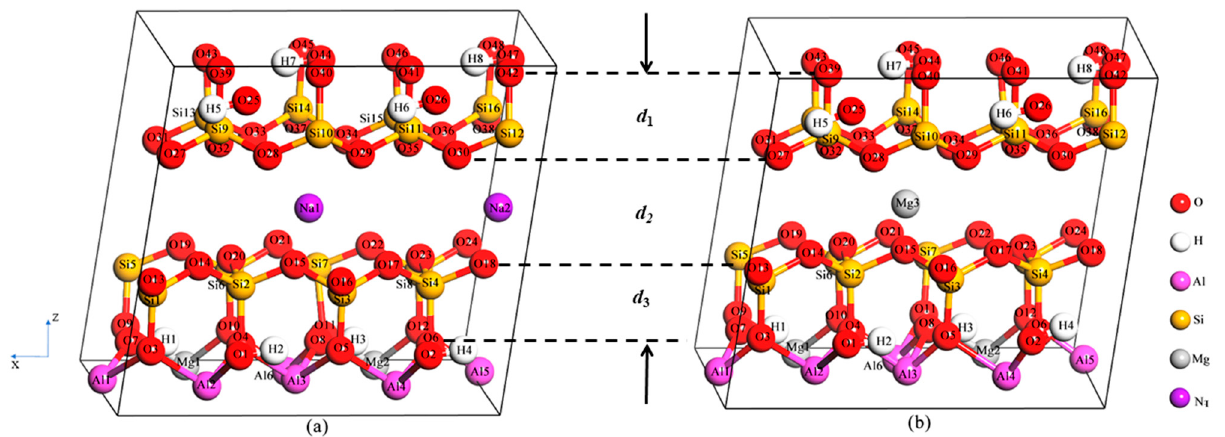
Figure 1. Unit cell of the Na-MMT ( a ) and Mg-MMT ( b ). White spheres = hydrogen; red spheres = oxygen; purple spheres = sodium; grey spheres = magnesium; yellow spheres = silicon and magenta spheres = aluminum. d 1 and d 3 —layer thickness of silicon oxide tetrahedral sheet, d 2 —interlayer thickness. Table 1. Calculated lattice parameters of the Na-MMT and Mg-MMT using basis sets were described in present study. Type Phase Na-MMT This work Mg-MMT